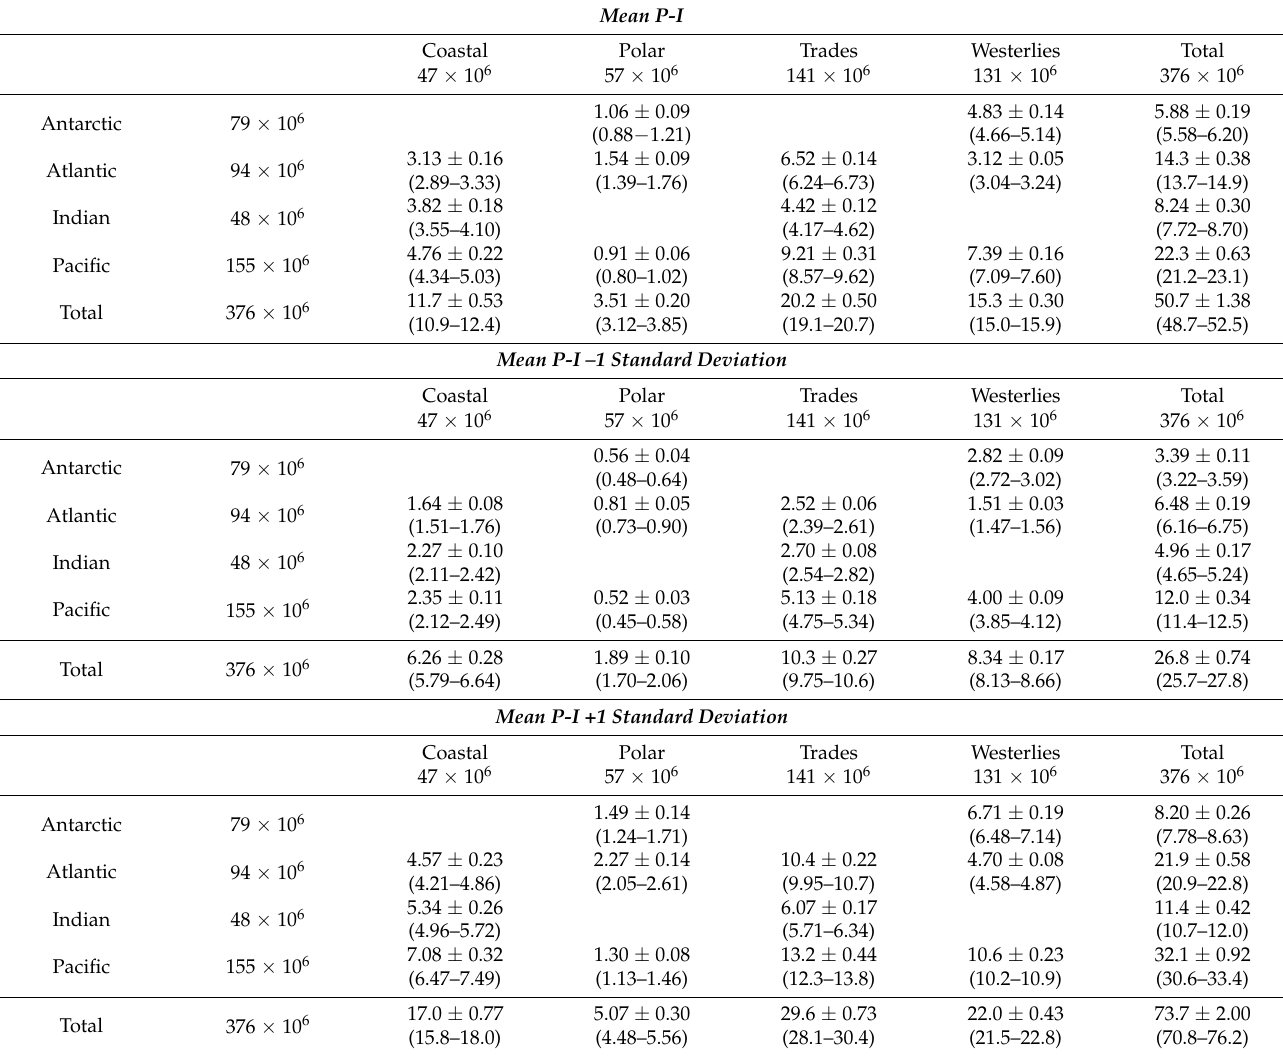
Table 2. Climatological mean and standard deviation ( n = 21) of annual primary production (in Gt C y − 1 ) between 1998 and 2018 for each ocean basin and biome as defined by Longhurst (2007). Range in annual primary production between 1998 and 2018 is given in parentheses. Results are given for primary production estimates based on mean, –1 standard deviation and +1 standard deviation photosynthesis versus irradiance (P-I) parameters. Surface areas (in km 2 ) for each ocean basin and biome are also